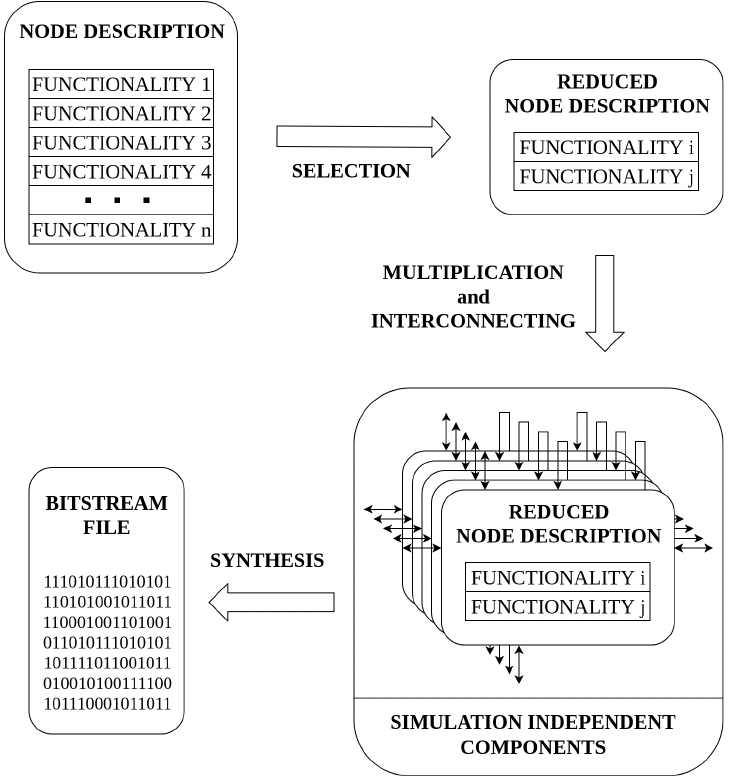
Figure 3. Preparation of the DSlave